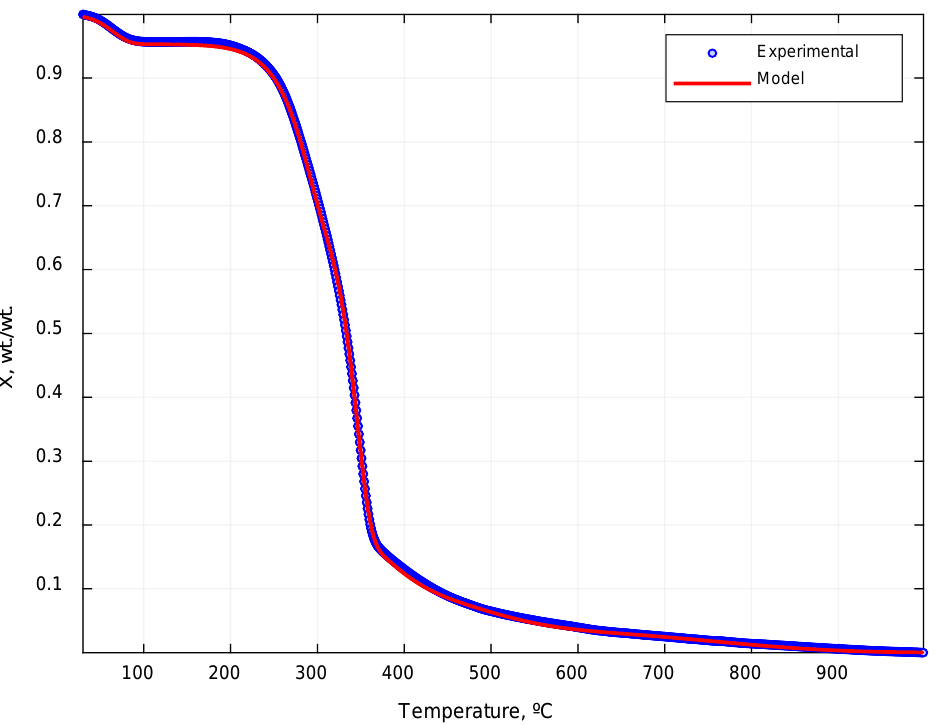
Figure 10. Model fitted to the experimental poplar TG curve.